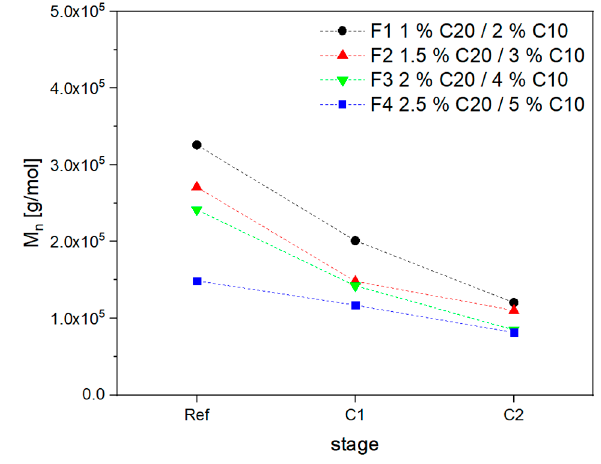
Figure 22. Number average molecular weight of the four formulations in different stages.